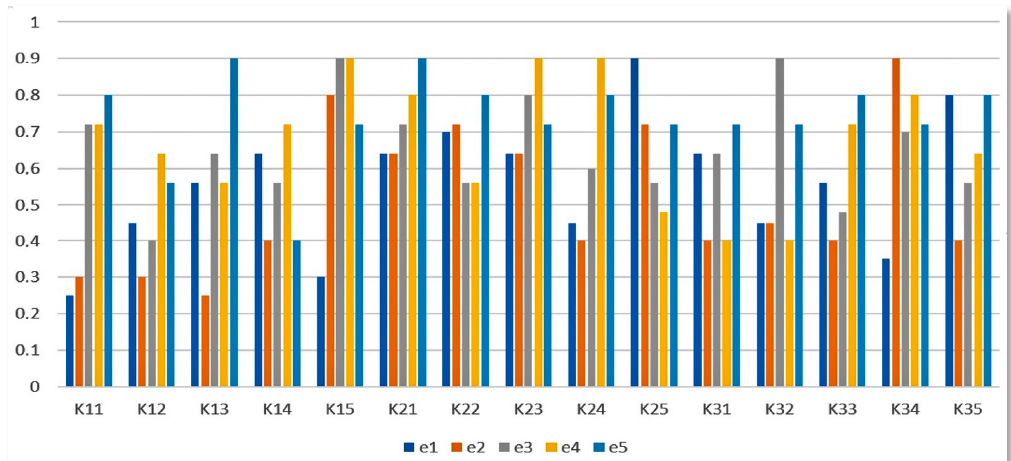
Figure 4. Fuzzification of input data.